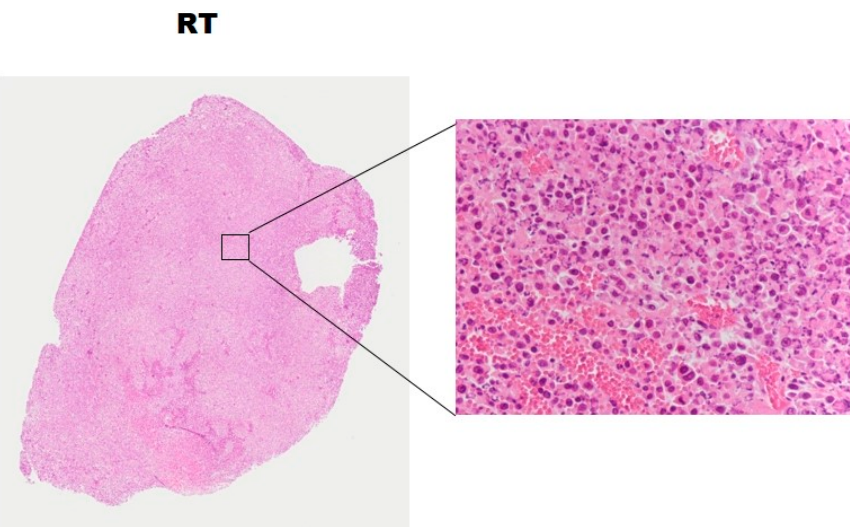
Figure 6. Hematoxylin and eosin stained tumor slices representative of the non-irradiated tumor and irradiated tumor at Day 3 post-irradiation. There is no majority of the necrotic area in the irradiated group.